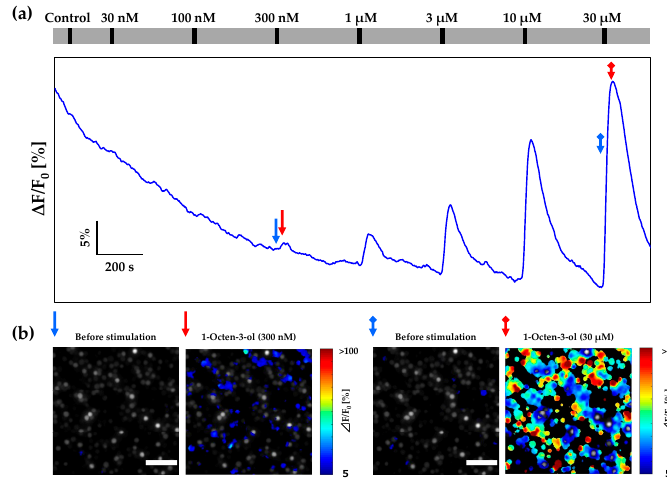
Figure 3. ( a ) Typical dose–response profiles of fluorescence intensity changes of Or13a cells in the 3D-printed cartridge during addition of 1-octen-3-ol at concentrations ranging from 30 nM to 30 µ M. These responses indicated average numbers of Or13a cells in the fluorescence-microscope field of view. The long grey bar indicates the perfusion of the assay buffer solution including 0.1% DMSO by the peristaltic pumps. The short black bars indicate when each odorant flowed inside the chamber for 15 s, and assay buffer solution including 0.1% DMSO was used as a control. ( b ) Pseudo-color heat maps of cell-response rates in the 3D-printed cartridge exhibited a > 5% increase in fluorescence intensity before and after stimulation with 300 nM and 30 μ M 1-octen-3-ol. The blue arrow and the blue arrow with a square tail in ( a ) indicate fluorescence intensity before 300 nM and 30 µ M 1-octen-3-ol stimulation, respectively, and correspond to the same arrows of the heat map shown in ( b ). The red arrow and the red arrow with a square tail in ( a ) indicate fluorescence intensity change peaks induced by stimulation with 300 nM and 30 µ M 1-octen-3-ol, respectively, and correspond to the same arrows of the heat map shown in ( b ). All scale bars are 100 µ